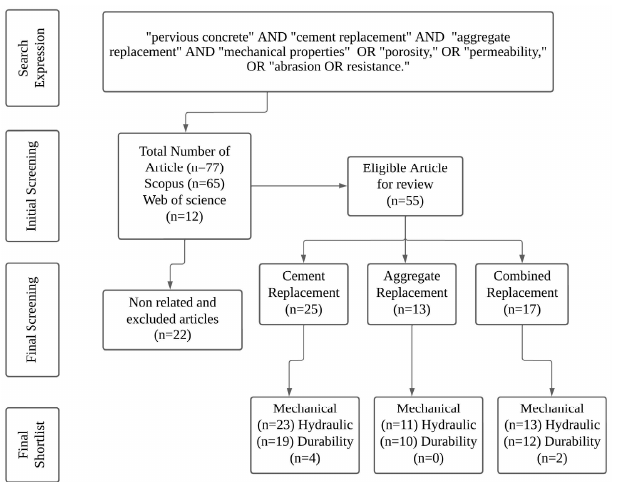
Figure 1. Flowchart of the methodology for selecting and screening the articles (n = number of articles).